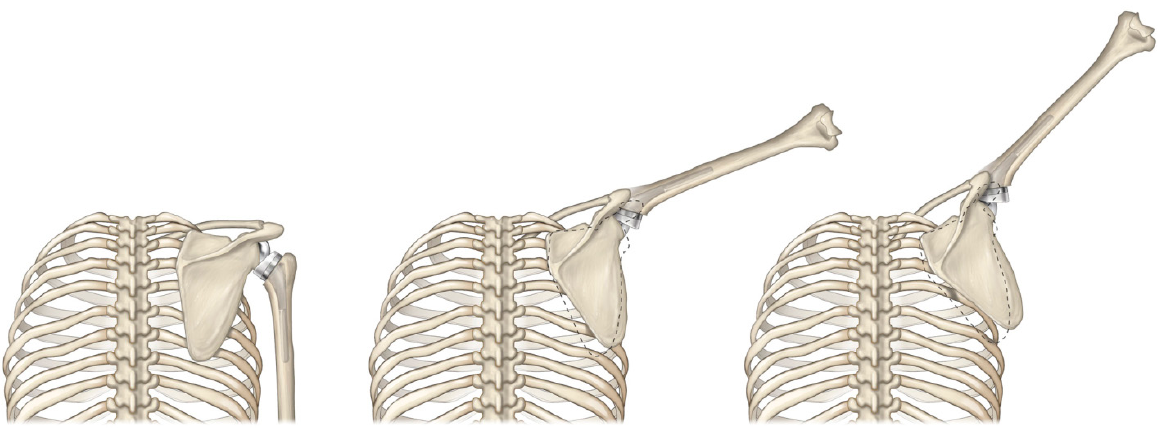
Figure 3. Modified scapulohumeral rhythm with rTSA, where additional scapular rotation occurs with rTSA relative to the scapulohumeral rhythm of the native shoulder (dotted line) during arm elevation.